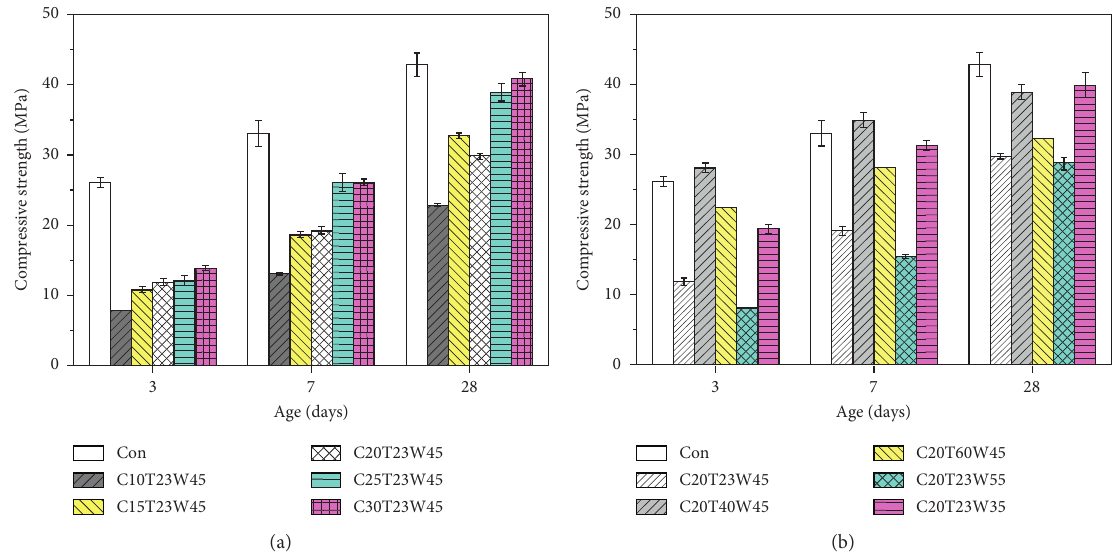
Figure 6: Compressive strength of mortars: (a) mortars with different contents of cement; (b) mortars prepared by different curing temperatures and w / b